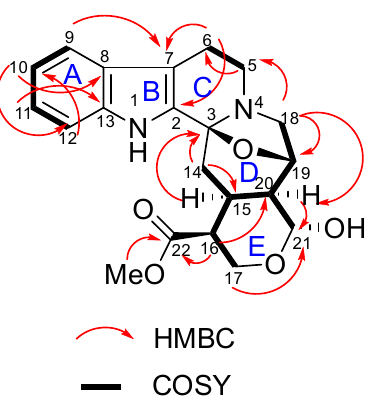
Figure 6. Selected key correlation of dihydrodeglycocadambine 7.